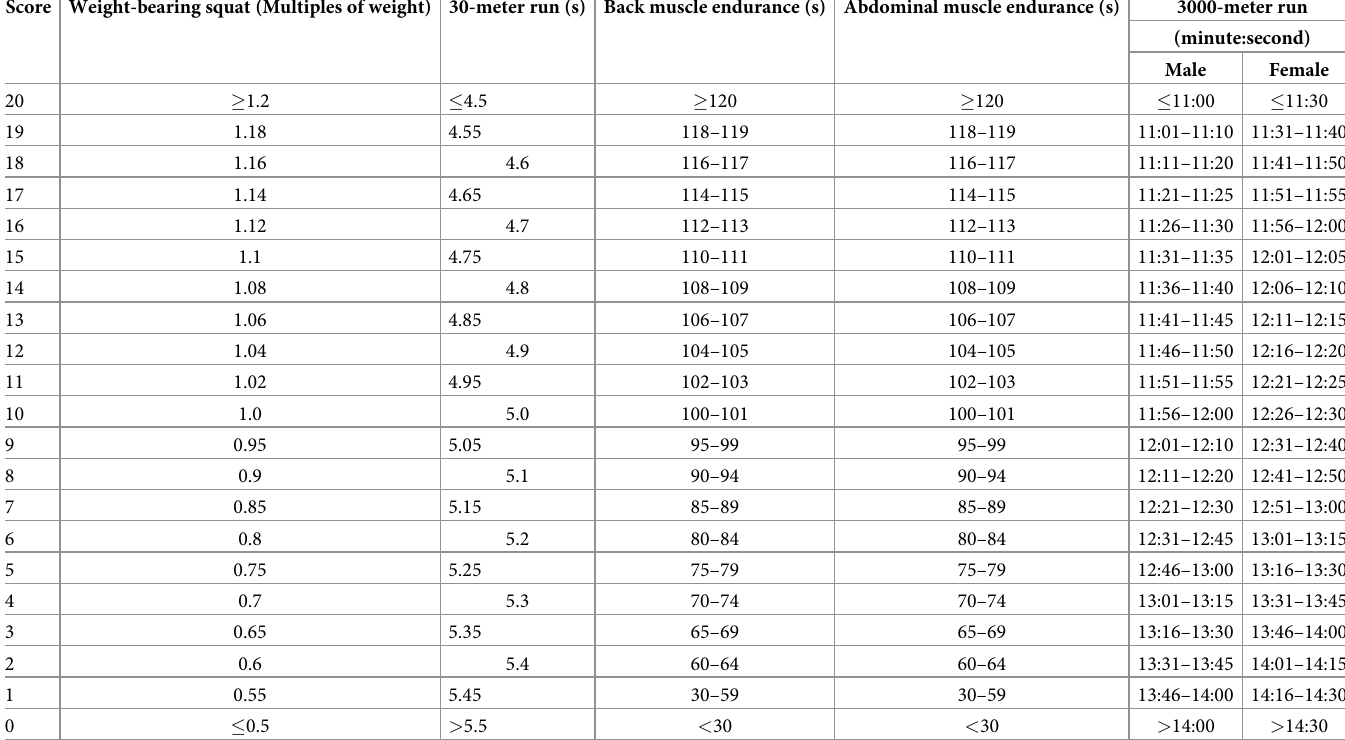
Table 2. Assessment matrix for the physical fitness